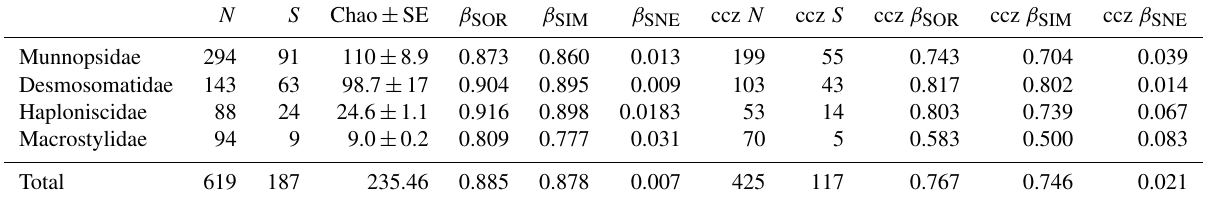
Table 3. Beta-diversity decomposition of isopod families. N signifies number of specimens, and S signifies number of species. β SOR, β SIM, and β SNE express multiple-site total beta diversity, multiple-site species turnover, and multiple-site nestedness, respectively. Columns